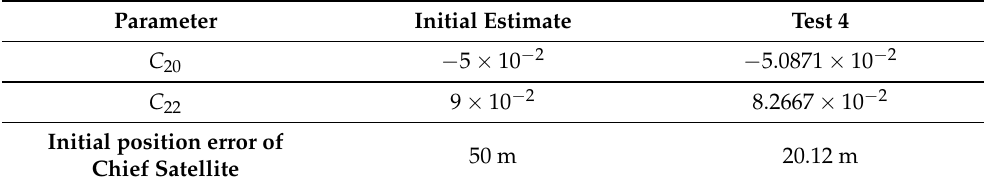
Figure 8. Residual in the observation data ( left ), norm of the position error of the determined orbit from the true one ( middle ) and orbits of spacecraft ( right ) (test 5 with 8 links). Table 6. Recovery result of test